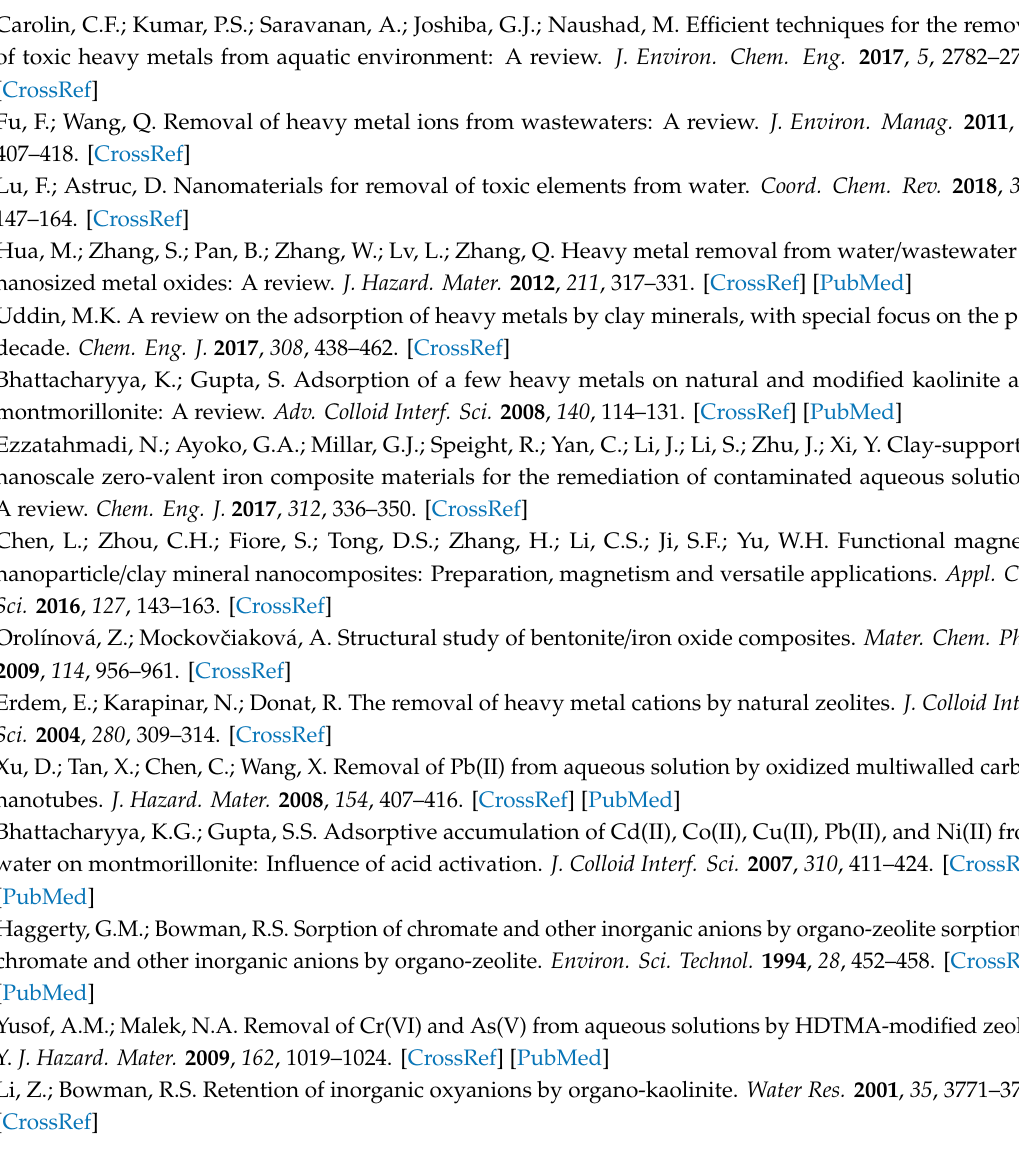
Figure S1: Thermal curves of (a) LDHM and (b) H-LDHM; Figure S2: XRD patterns of the LDH material after adsorption in multi-element wastewaters; Figure S3: FTIR spectra of the LDH material after adsorption in multi-element